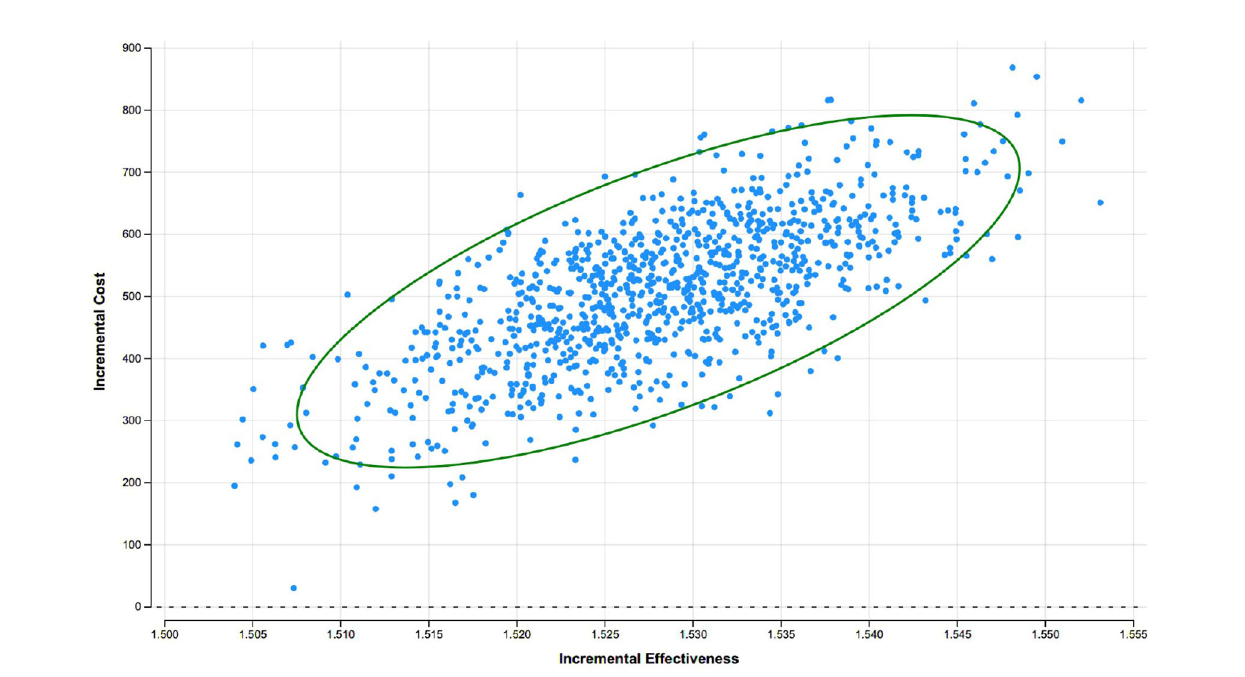
FIGURE 4 | Cost-effectiveness plane rSBRT vs. rRP at 10 years: results of the probabilistic sensitivity analysis with a Monte Carlo simulation showing the dispersion of 1000